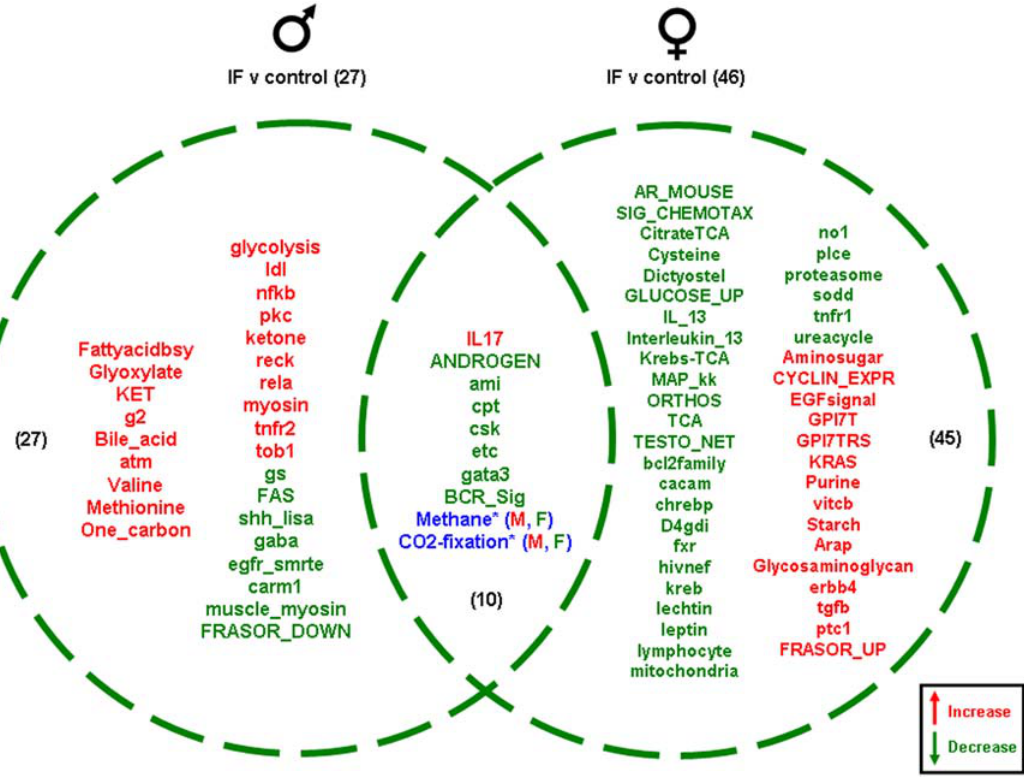
Figure 11. Pathway changes in the gonads of male and female rats maintained on the IF diet compared to the gonads of male and female rats maintained on the control ( ad libitum ) diet. Significantly regulated, functional pathway clusters were generated from the respective male or female gene sets using PAGE gene set analysis. Pathways that were significantly up-regulated (red) or down-regulated (green) were clustered into a Venn diagram. Pathways in blue were common to both males (M) and females (F) but were differentially regulated. Names of the significantly altered pathways can be found in Table S2.